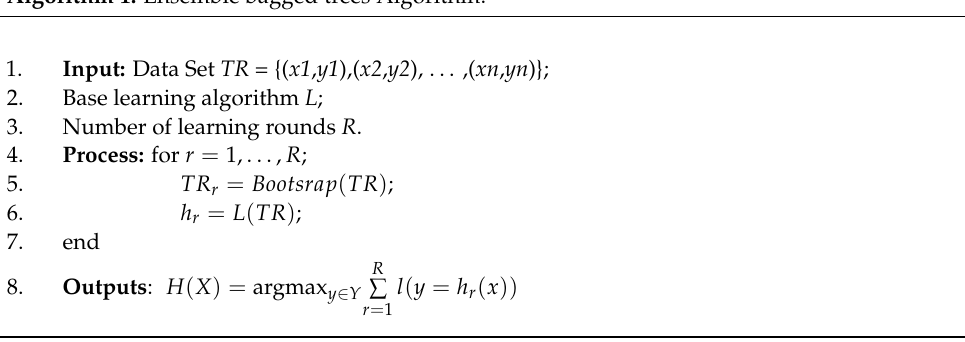
Figure 2. The overall flow chart of the proposed technique. 2.5. Machine Learning Techniques Performance in Fault Detection This section illustrates how the performance of an artificial intelligence (AI) tech- nique is evaluated using VMD based on IMF mode-3. This framework examines and com- pares five AI techniques for fault detection: linear discriminant, linear SVM, cubic SVM, ensemble boosted tree and EBTM. Indeed, accuracy is a statistical criterion employed to evaluate the efficiency of MLTs. Accuracy evaluates the reliability between expected and normal situations for both healthy and faulty events concurrently. It can be determined utilising Equation (6). ( ) ( )  +   +   